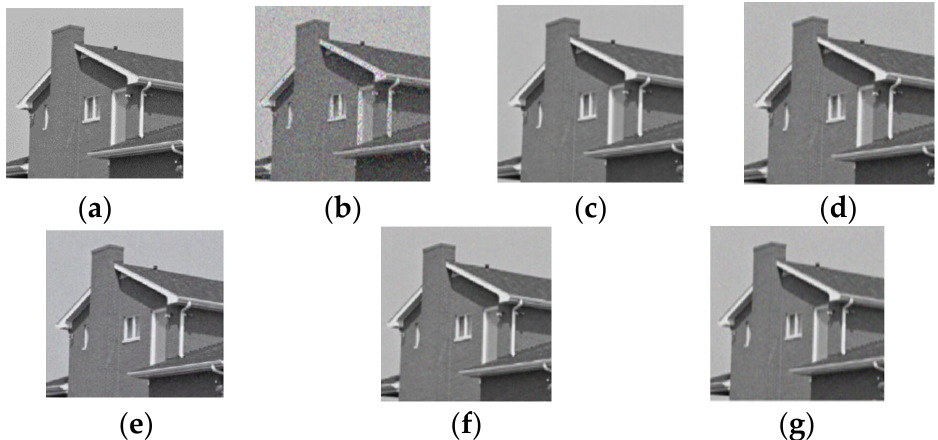
Figure 5. Image denoised using different methods. ( a ) original image, ( b ) noise image, ( c ) this paper, ( d ) MB3D, ( e ) DnCNN, ( f ) FFDNet, ( g ) IRCNN.